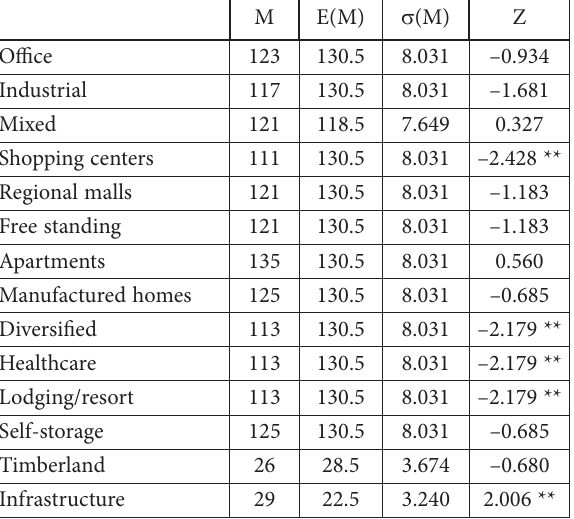
Table 2. Non parametric runs test